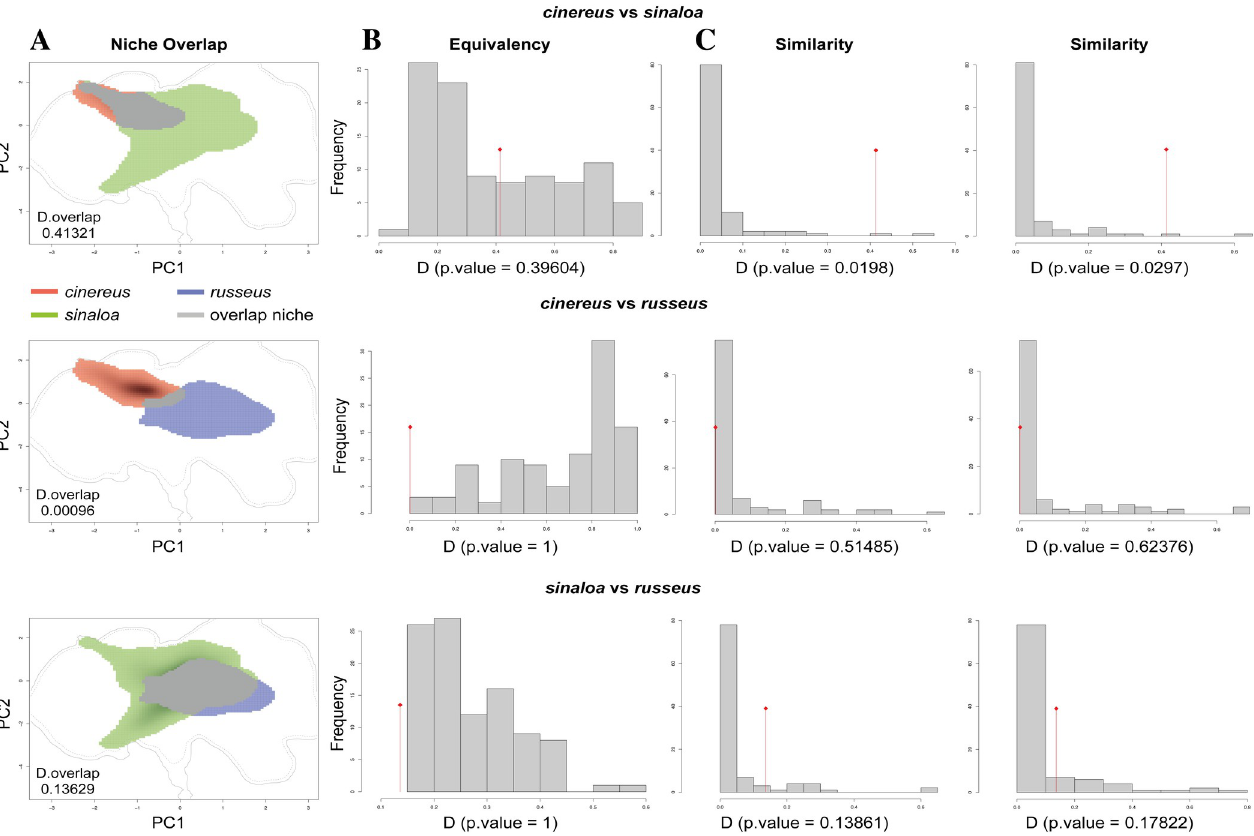
Fig 4. Graphical results of niche overlap, equivalence and similarity tests in environmental space for Sinaloa Wren. A. Graphical results of environmental niche overlap between pair of subspecies (gray areas) obtained from an ordination approach; B. Niche equivalence test between pair of subspecies, if the observed D values falls within the 95% density of simulated values, the null hypothesis of niche equivalency cannot be rejected; C. Similarity test between pair of subspecies in both directions, niche conservatism is accepted when the observed D values for niche overlap are significantly different ( P < 0.05) from simulated values of